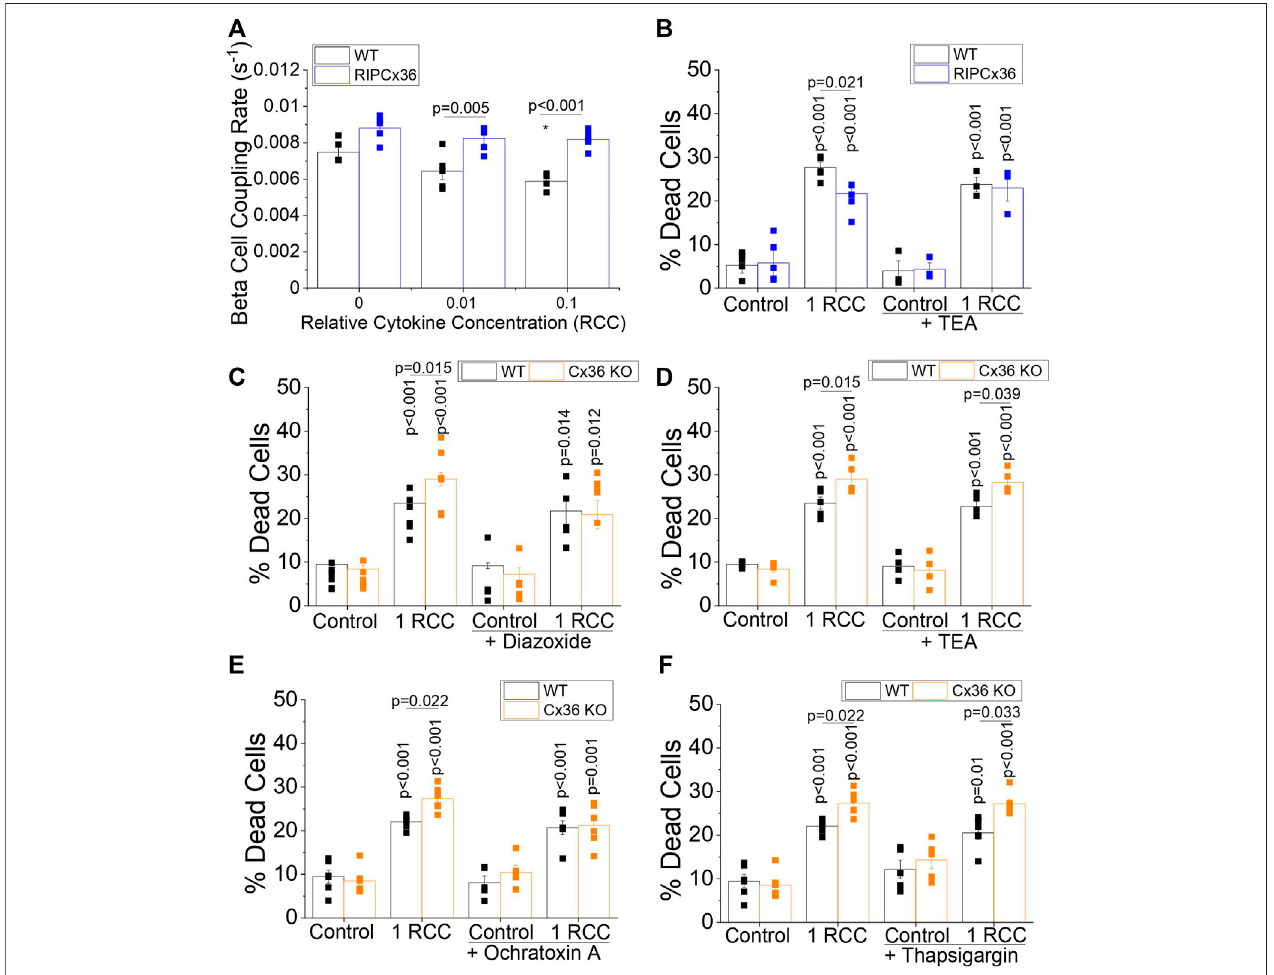
FIGURE 4 | Modulation of Cx36 Coupling and Intracellular Ca 2+ Mediate Cytokine-Induced Islet Death. (A) β -cell coupling rate as measured by FRAP in islets from WTandRIPCx36micetreatedwith0,0.01,or0.1relativecytokineconcentration(RCC)for24 h( n =5). (B) PercentcelldeathisletsfromWTandRIPCx36micetreated withor without cytokines (1RCC)and withor withoutthe K + channel inhibitor TEA for 24 h ( n = 3 – 5). Percentcell death in islets from WT and Cx36 KO mice treated with or without (C) 250 nM oftheK ATP channel activator Diazoxide ( n =5) or (D) 20 mMofthe K + channel inhibitor TEA ( n =3) withor without acytokine cocktail and for 24 h. Percent cell death in WT and Cx36 KO islets treated with or without (E) 1 µM of the SERCA activator Ochratoxin A ( n = 5) or (F) 1 µM of the SERCA inhibitor thapsigargin ( n = 5) with or without cytokines (1 RCC) for 24 h. Data represent the mean ± SEM. p < 0.05 is signi fi cant as determined by ANOVA. * Indicates p < 0.05 compared to untreated controls in